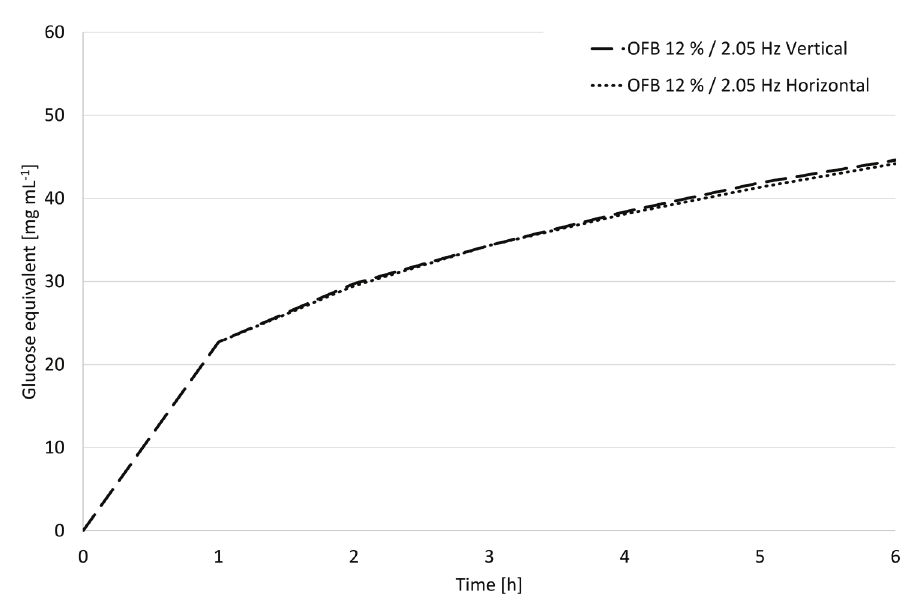
Fig. 9 – Sugar formation in horizontal and vertical position of the OFB reactor module (12 % SL; α-cellulose, 2.05 Hz, 10 mm amplitude, 2 mm baffle, 10 FPU, 50 °C, 6 h)